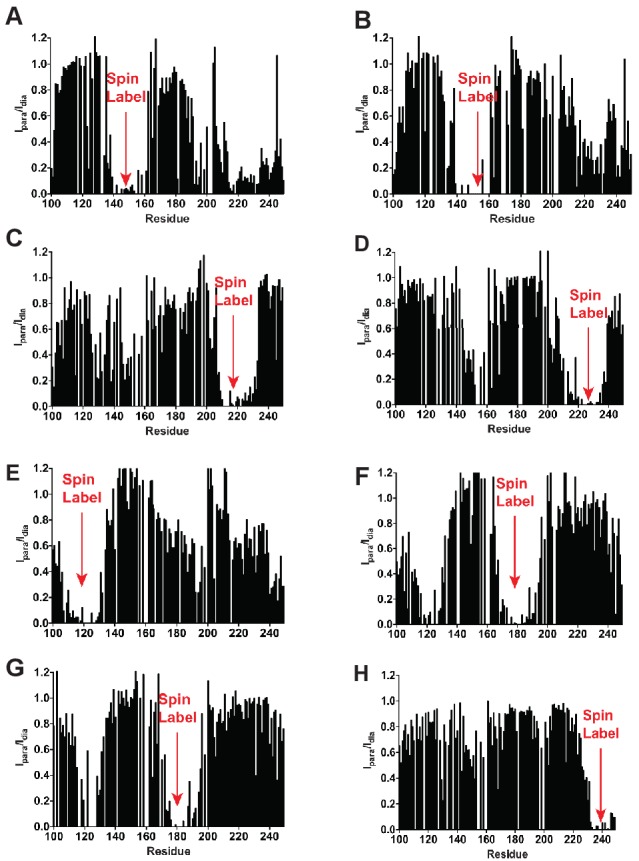
Long range PREs are consistent with the expected KCNQ1 VSD topology in LMPG micelles.The residue positions of the spin-labeled cysteines for each sample are : (A) 144-SL (B) 155-SL (C) 214-SL (D) 224-Sl (E) 121-SL (F) 177-Sl (G) 180-SL (H) 238-SL.Figure 1—figure supplement 1—source data 1.Excel file with numerical data used for Figure 1—figure supplement 1.